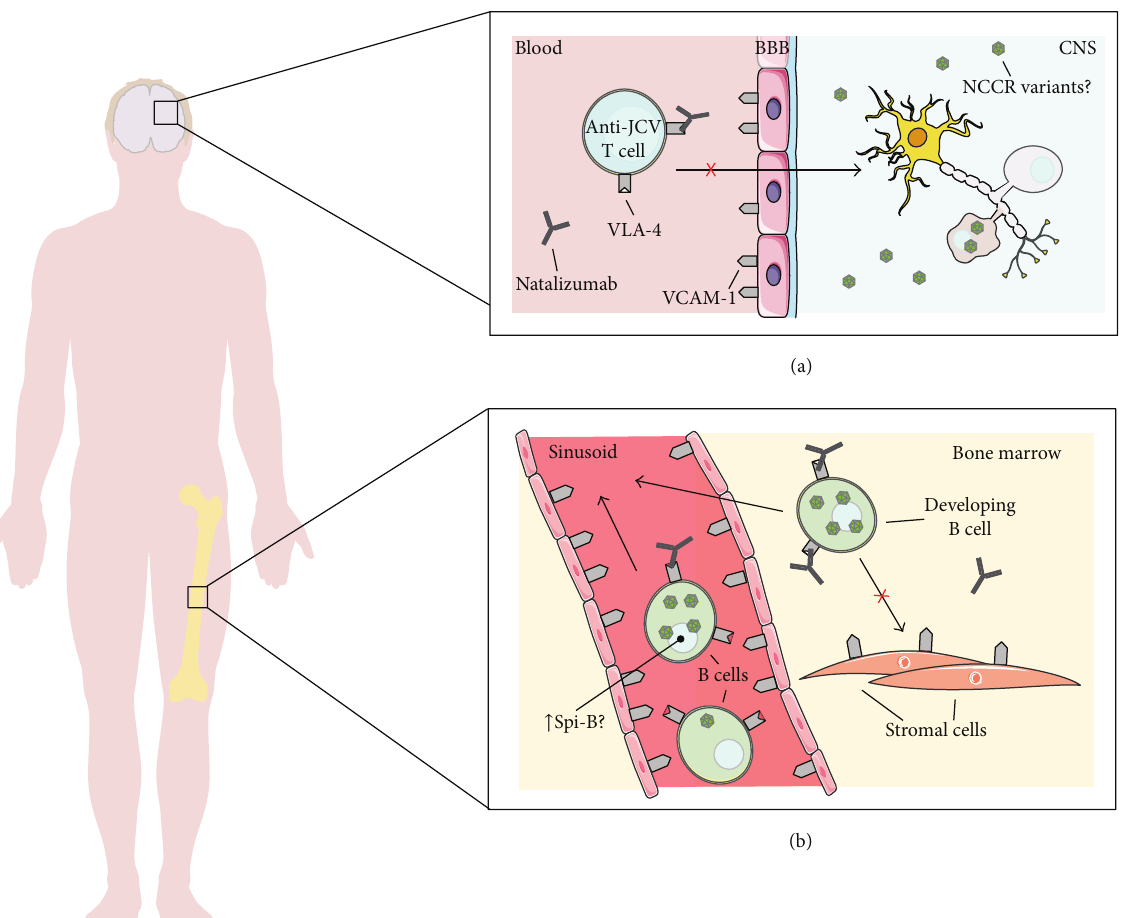
Figure 1: Development of progressive multifocal leukoencephalopathy during natalizumab treatment. This figure summarizes the three hypotheses on how natalizumab may lead to PML. (a) Natalizumab may prevent the entry of JCV-specific cytotoxic T cells into the brain, necessary for the control of latent JCV within infected oligodendrocytes. (b) Natalizumab inhibits the VLA-4-dependent homing and retentions of lymphocytes in bone marrow (sites of JCV latency), thus leading to an increase of JCV-infected peripheral leukocytes. Finally, another possible factor is the natalizumab-induced expression of Spi-B, a transcription factor that has been shown to increase JCV